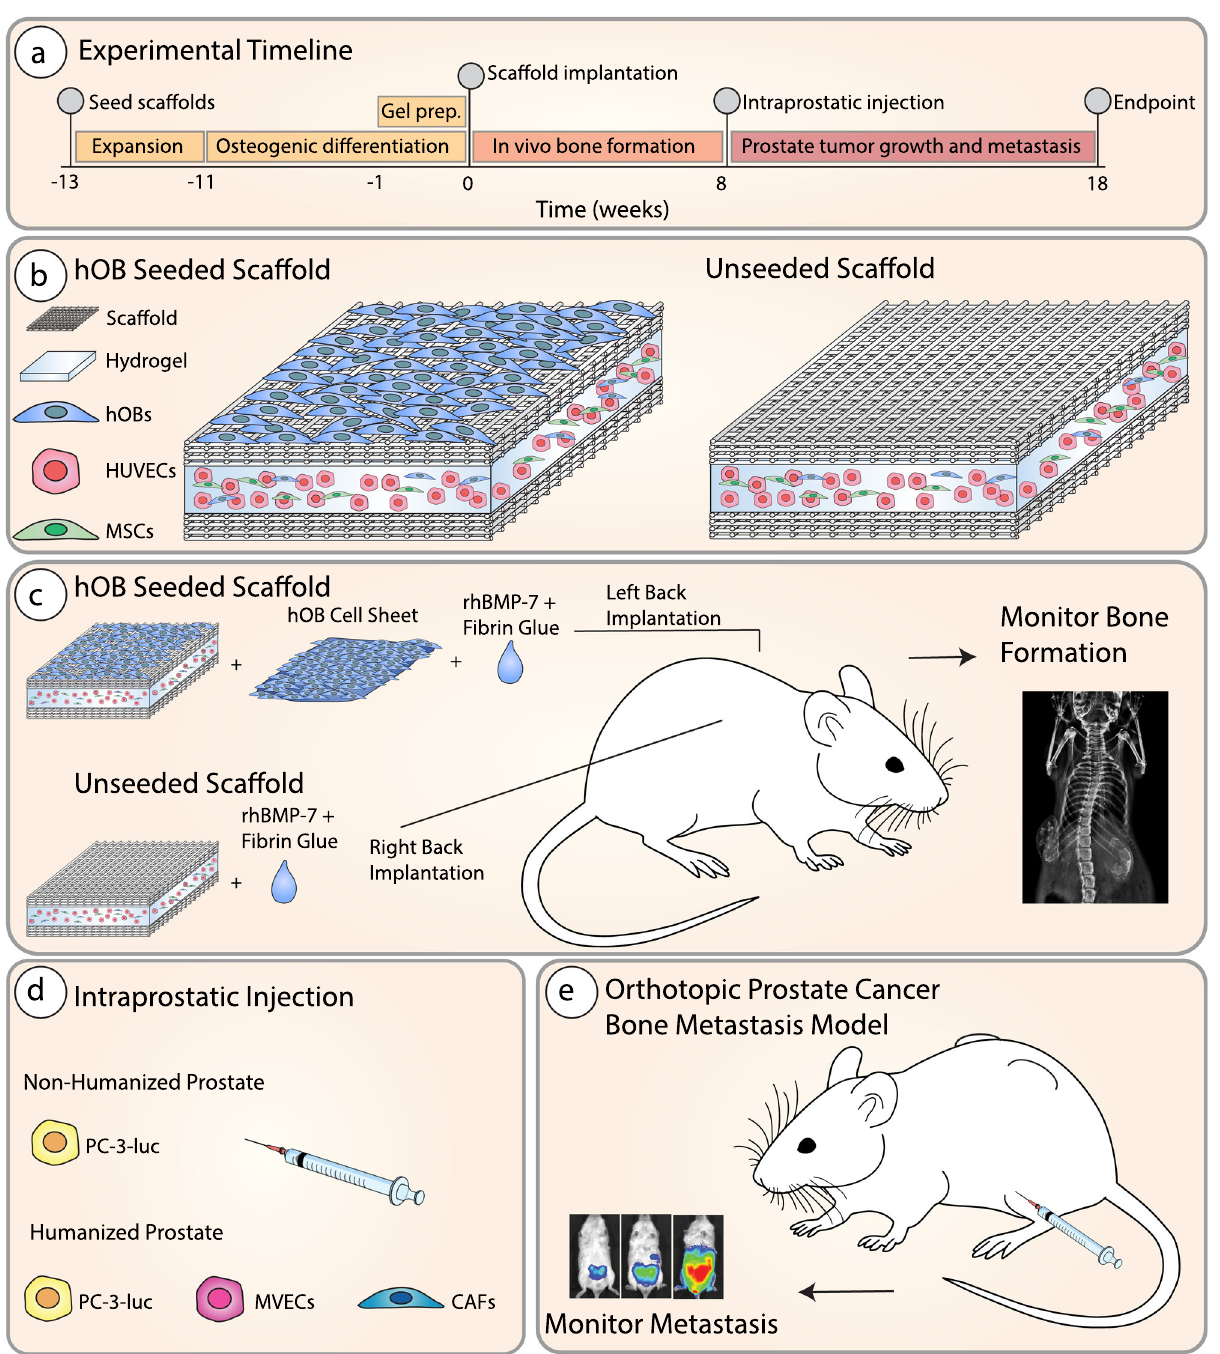
Fig. 1 Schematic of experimental design. a Overview of the experimental timeline for the study. The human tissue-engineered bone construct (hTEBC) was created by seeding human osteoblasts (hOBs) onto quadratic calcium phosphate-coated melt electrowritten medical-grade polycaprolactone (mPCL) scaffold sheets with 95% porosity. The hOBs formed a dense cell/extracellular matrix (ECM) network throughout the scaffold architecture over 2 weeks before culture conditions were switched to osteogenic media for 11 weeks. b One week before implantation, star-shaped polyethylene glycol (sPEG) heparin gels were prepared containing hOBs, human mesenchymal stromal cells (MSCs), and human umbilical vein endothelial cells (HUVECs) and cultured to form capillary-like networks. A total of n = 10 mice were used for this study. Prior to subcutaneous implantation the sPEG-heparin gels were sandwiched together between two quadratic in vitro-engineered constructs. c The left-back of the male NSG mice received in vitro engineered constructs seeded with hOBs and combined with hOB cell sheets within the fi brin glue (in n-10 mice), whereas the right-back received unseeded scaffolds with the cell-loaded sPEG-heparin gel (in n = 10 mice). Both the cell-laden and cell-free in vitro engineered constructs were combined with recombinant human bone morphogenetic protein-7 (rhBMP-7) and fi brin glue immediately prior to implantation. The bone was allowed to develop for 8 weeks before intraprostatic injection and monitored using X-ray. d Humanization of the mouse prostate was performed via injection of PC-3-luc cells together with prostate lymphatic and blood vessel endothelial cells (BVECs) and PCa-derived fi broblasts (CAFs) performed in n = 5 mice, whereas the non-humanized group received an intraprostatic injection of PC-3-luc cells alone performed in n = 5 mice. e Growth of the primary prostate tumor and metastasis to distant organs were monitored weekly using in vivo bioluminescent imaging for 10 weeks. The mouse schematic image was sourced from Wikimedia Commons 52 . COMMUNICATIONS BIOLOGY| (2021) 4:1014 |https://doi.org/10.1038/s42003-021-02527-x|www.nature.com/commsbio